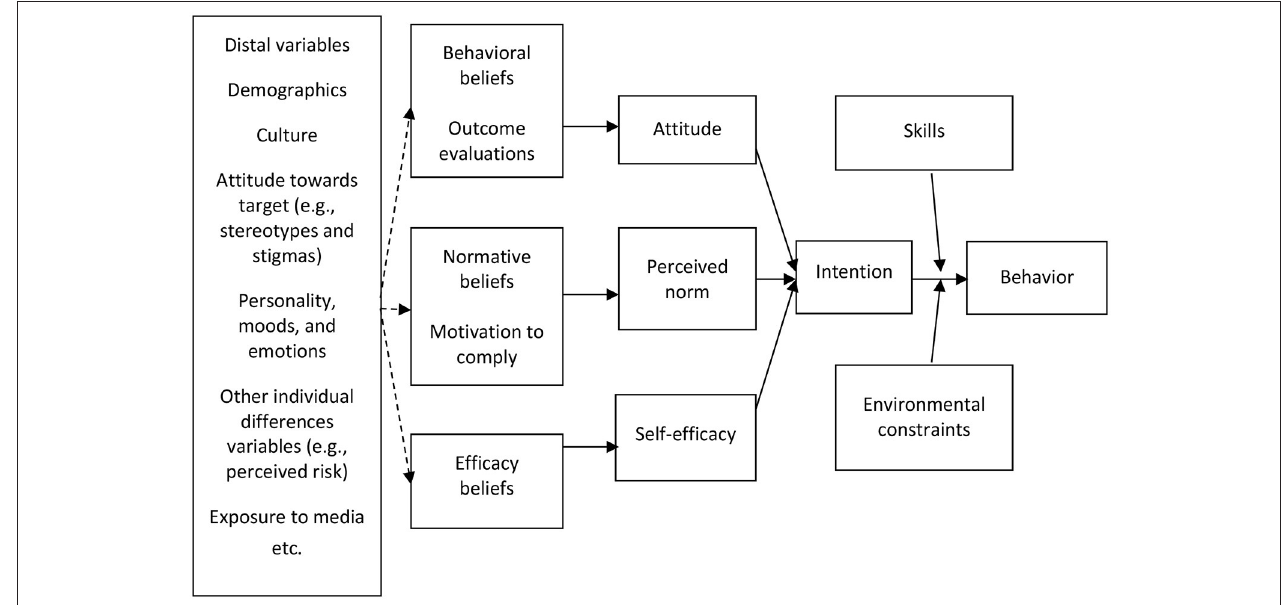
FIGURE 2 | The integrative model of behavioral prediction (Fishbein, 2000,